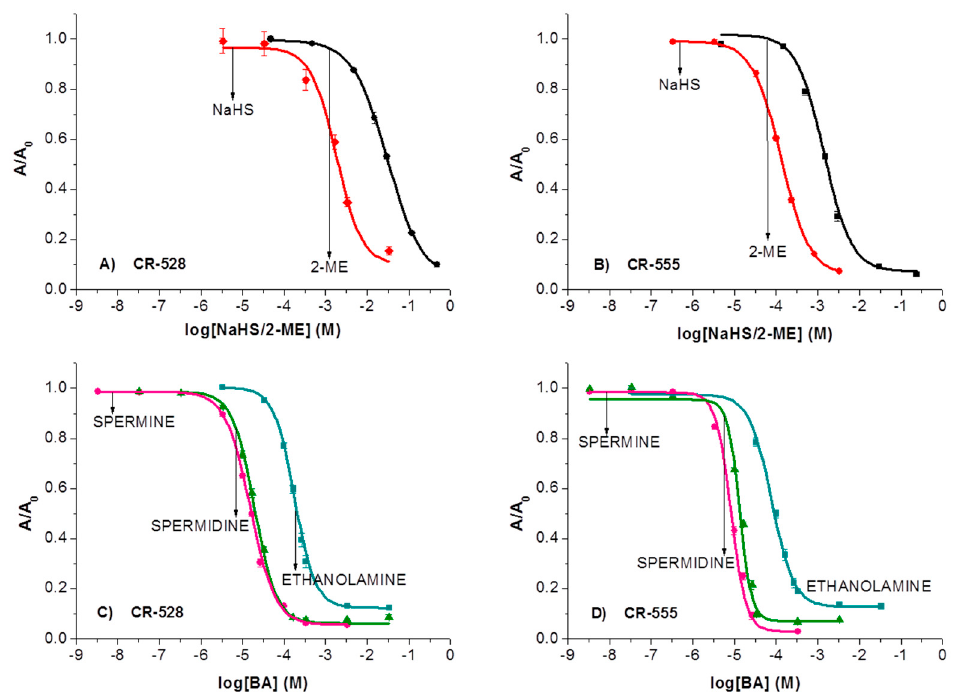
Figure 6. Spectrophotometric titrations (calibration curves) for sulfur-based analytes (NaHS, 2-ME; ( A , B )) and for amine-based (BA) analytes (spermine, spermidine, ethanolamine; ( C , D )); n = 3. Table 1. Analyte structures and their reactivity with CR-528 and CR-555. Analyte Structure